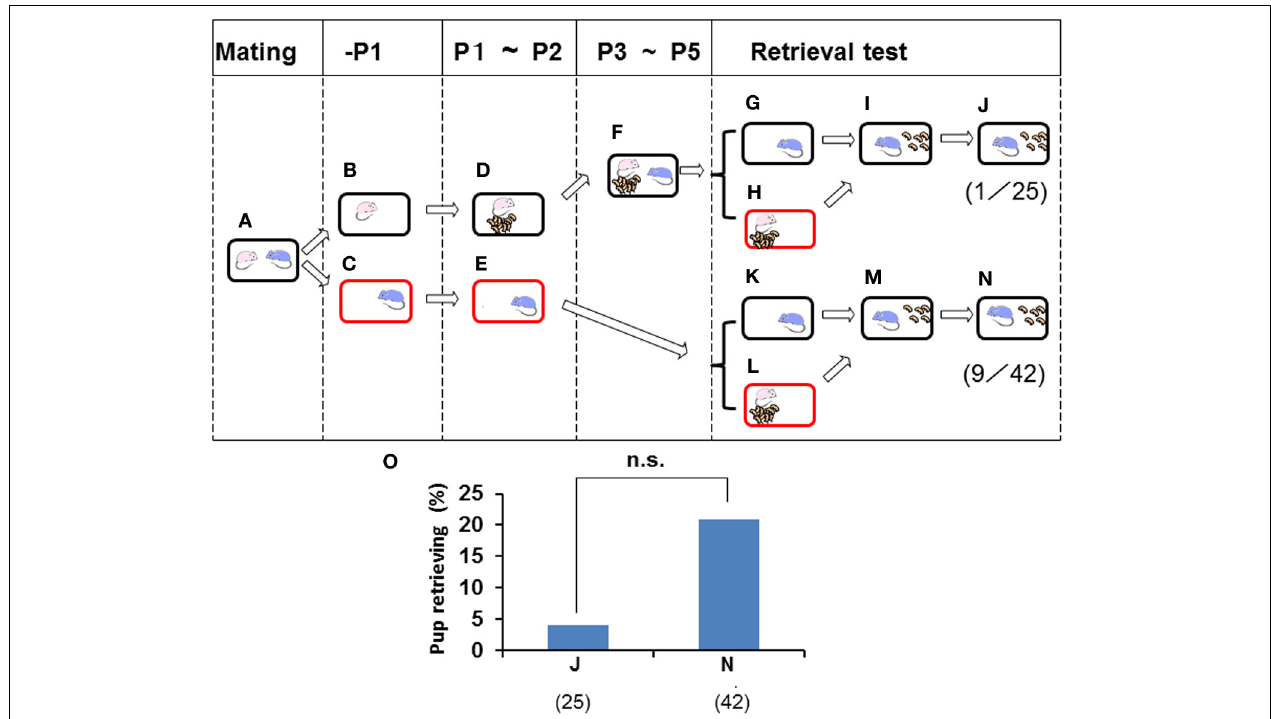
FIGURE 3 | Paternal retrieval test in ICR mice isolated prior parturition from the mating pair and then united as a whole family. A paired couple was kept in a rearing cage from mating (A) to 1 day before parturition, and the female and male were then kept in a home cage (B) or in a new cage (C) . The next day, the female delivered her pups (D) and remained until postnatal day 2 (P2). The male was kept continuously in the new cage until P2 (E) . From P3 to P5, the sire was introduced to the